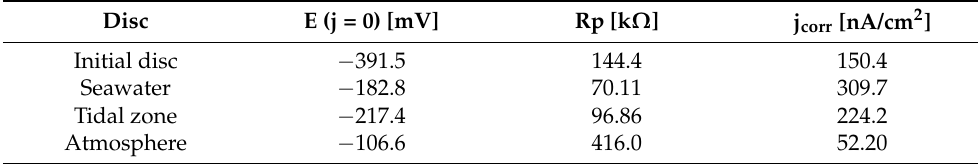
Figure 7. Results obtained through the polarisation resistance method (linear polarisation). Table 2. Results obtained through the polarisation resistance method (linear